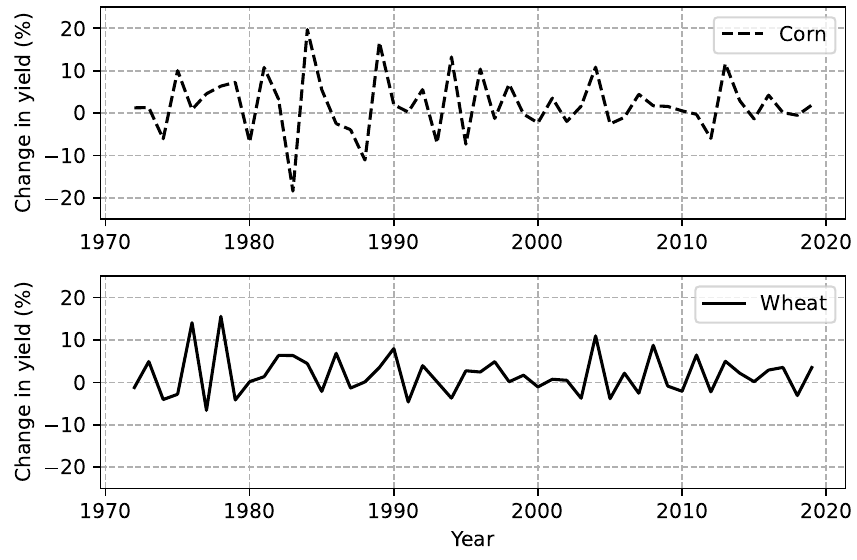
Figure 3. Annual percent change in corn ( top panel ) and wheat ( bottom panel ) yields,